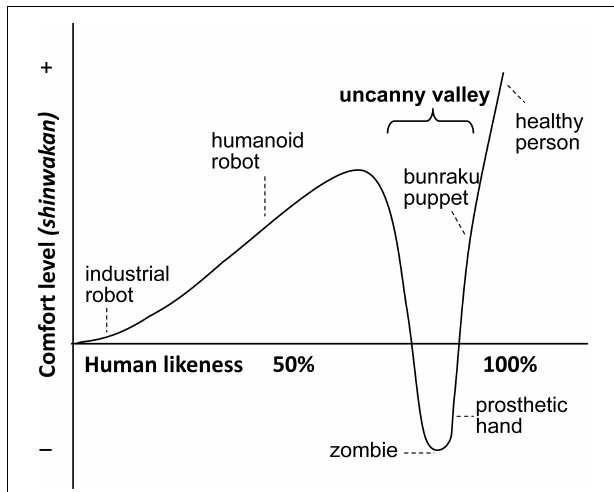
FIGURE 1 | A modified reproduction of Mori’s (1970) original ‘uncanny valley’ hypothesis by showing only the reaction to moving